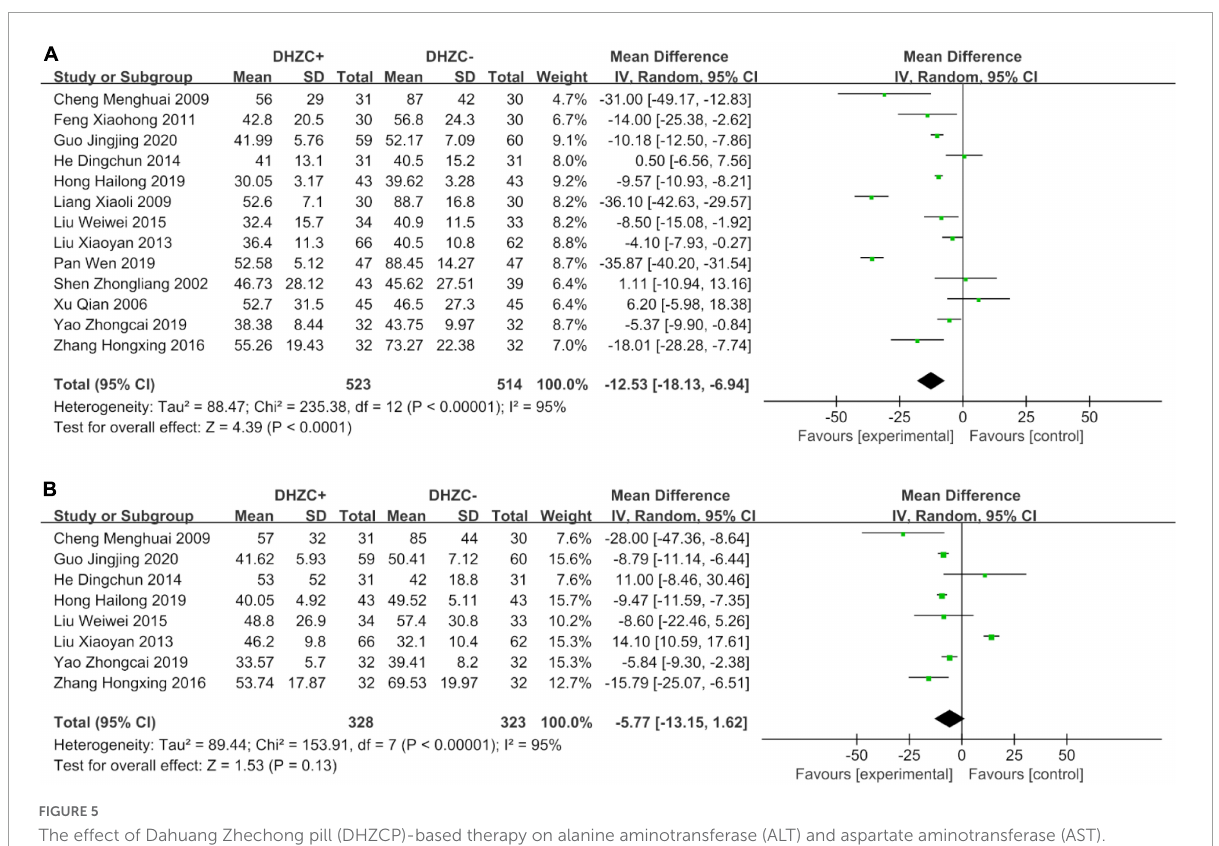
− 12.60 to − 5.13; p < 0.00001, I 2 = 63%). The AST